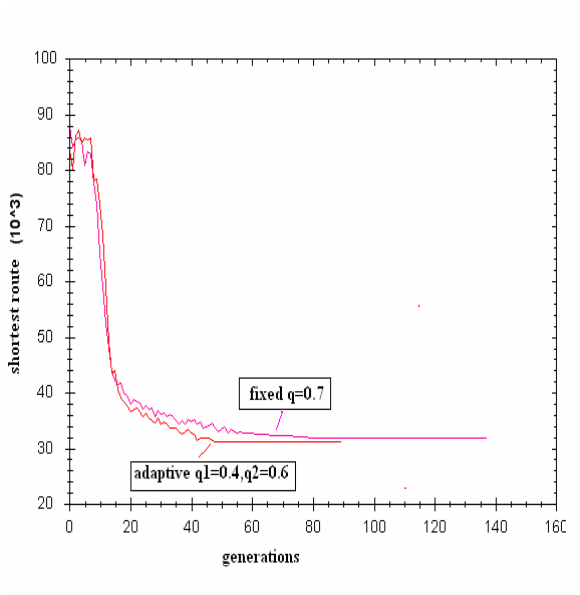
Figure6. The average result 1 of TSP benchmark instances Chn144 by different parameter